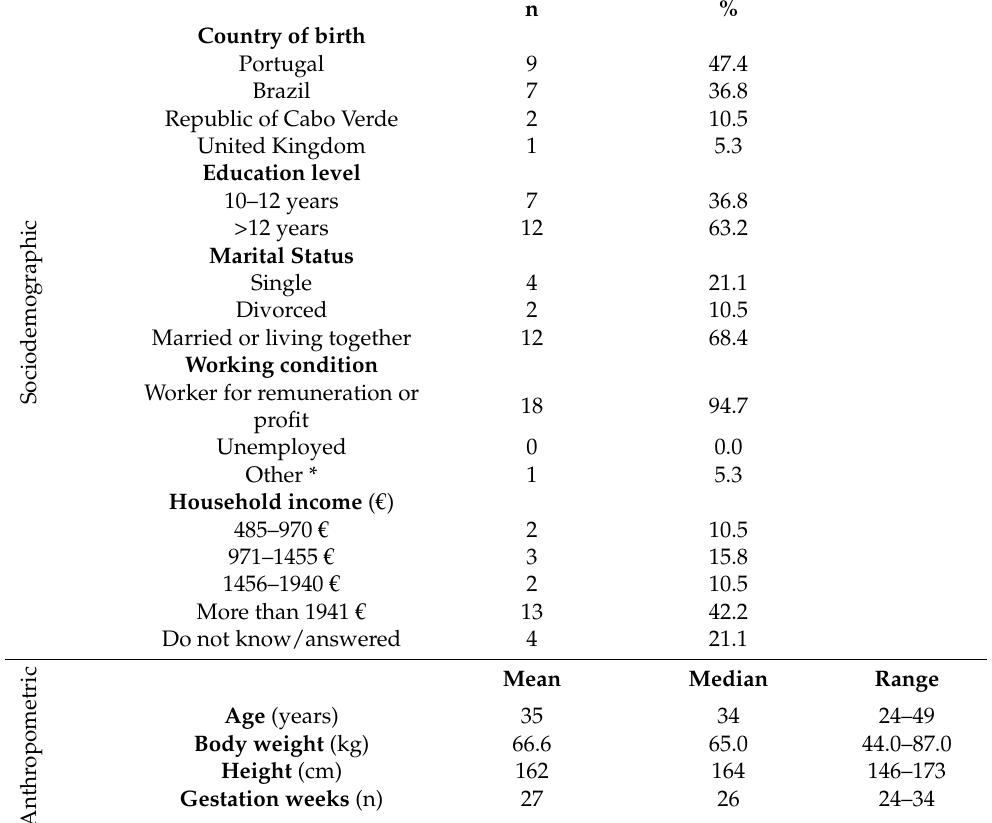
Table 1. Characterization of participants (mothers) in the earlyMYCO pilot study (n =